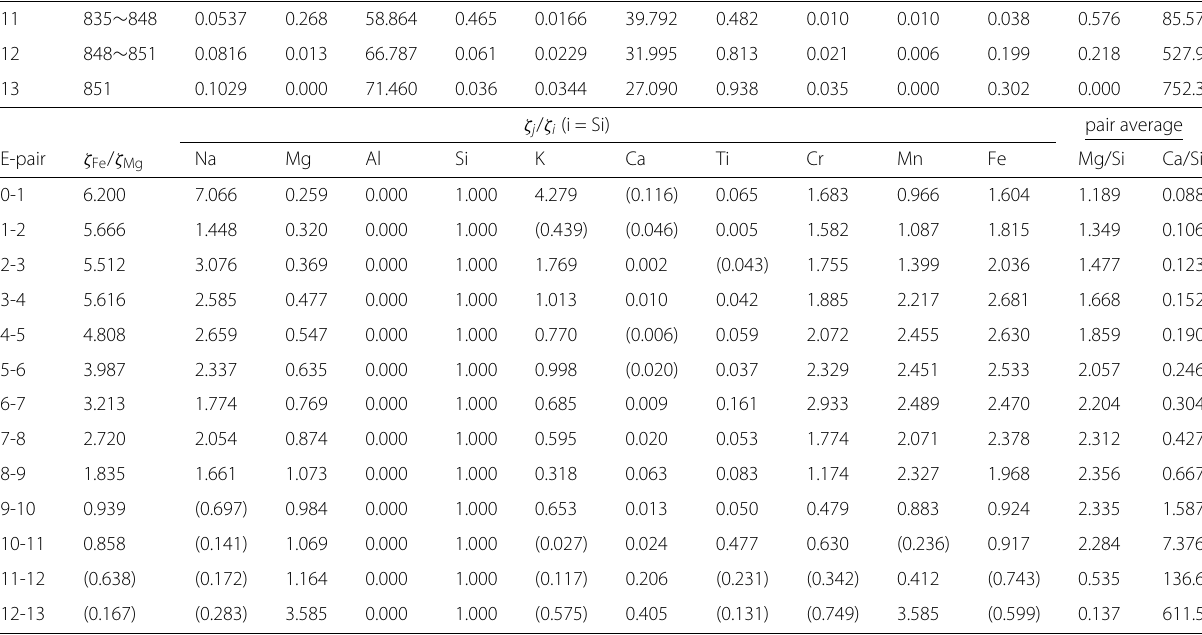
Table 4 Average chemical compositions of 13 ensembles (upper sections) and relative volatilities of elements (lower sections) ( Continued